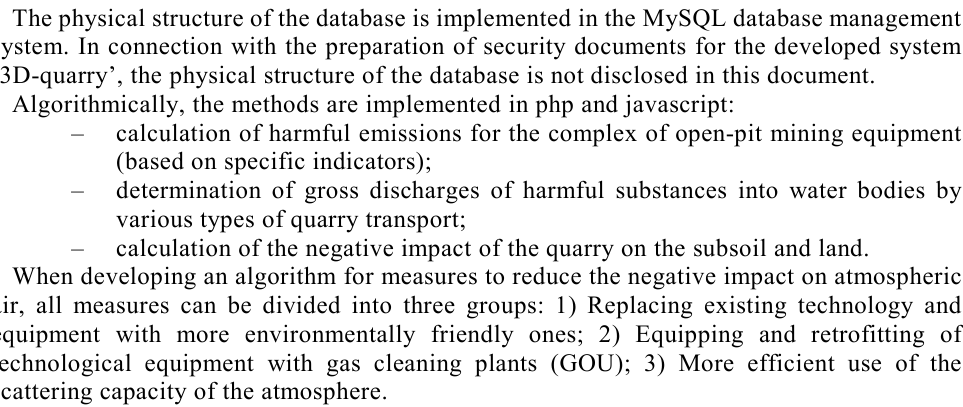
Fig. 2. Additions to the logical model of the data structure for the ‘EIA’